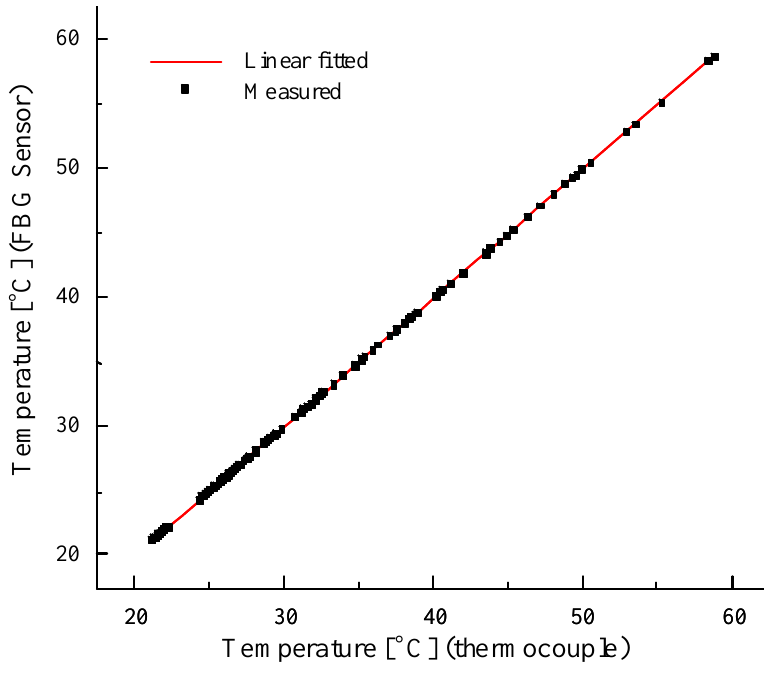
Figure8. FBG sensor vs. reference thermocouple